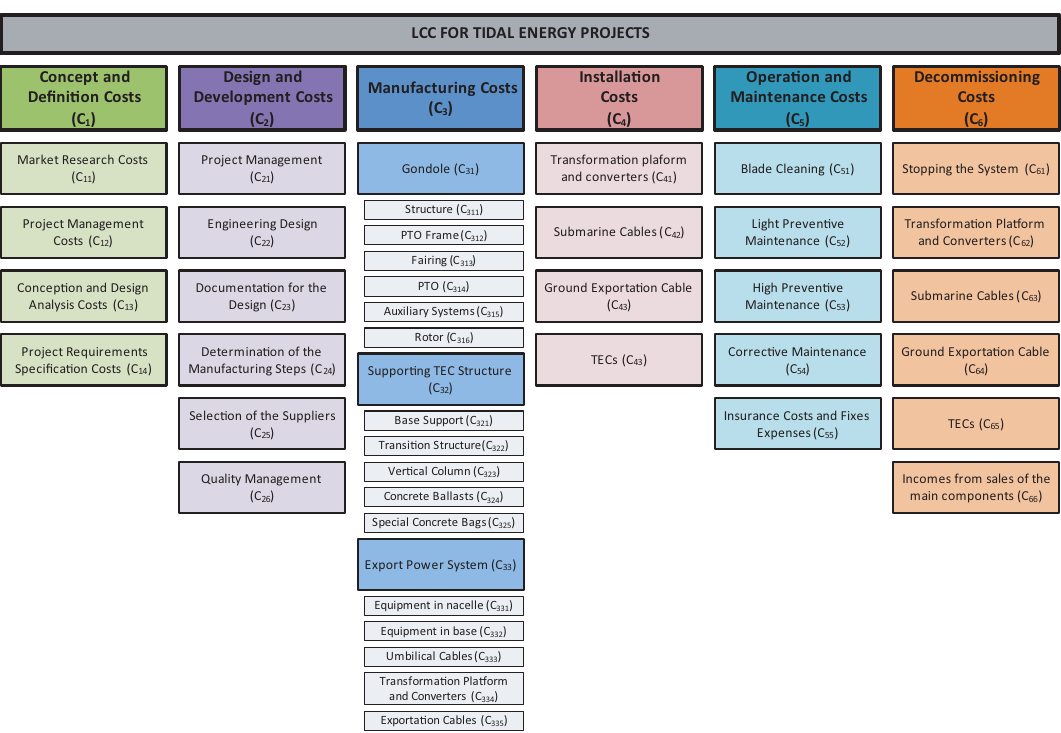
Figure 1. Cost and sub-costs for the proposed methodology. LCC, life-cycle costs; TEC, tidal energy